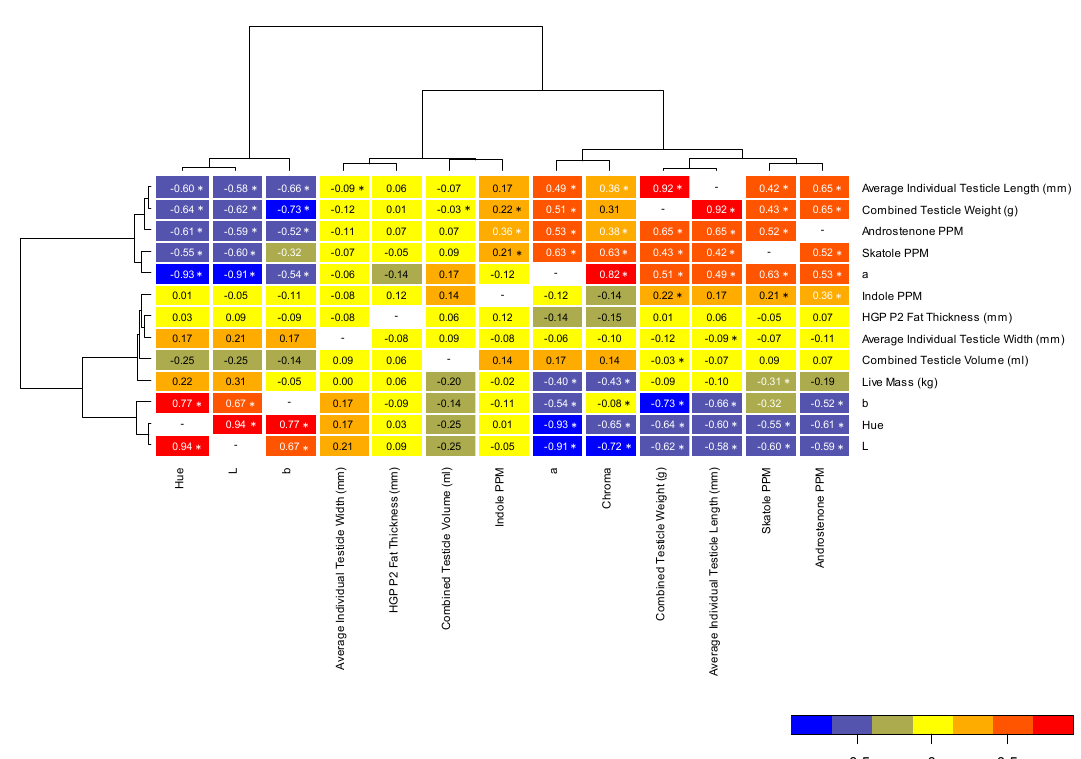
Table 5. The concentrations (µg/g) of androstenone, skatole and indole in the adipose tissue of immunocastrated and entire male pigs, fed varying protein diets, with or without ractopamine hydrochloride for the last 28 days of finishing. Results are reported as LS Mean ± SEM.